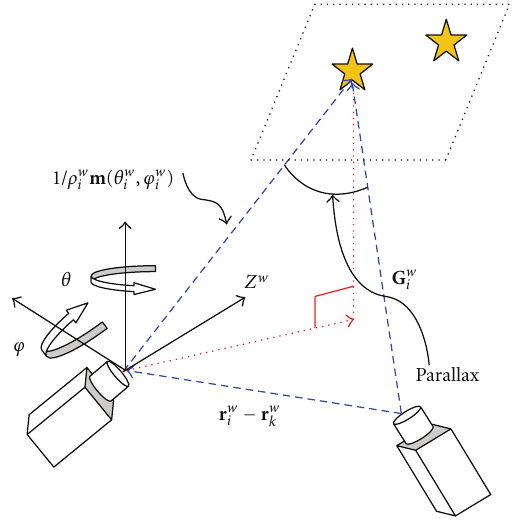
Figure 1: The robot moves from r w views, the parallax is produced. The initial depth can be refined to approach the real distance and the position of the i th target is